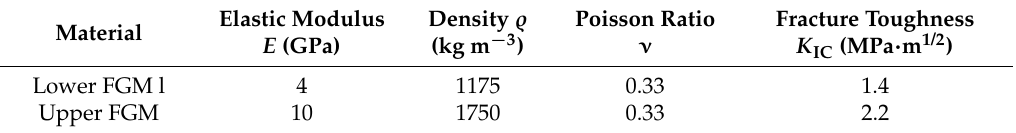
Figure 3. Specimen geometric and boundary conditions. Table 1. Material parameters of functional gradient material (FGM) coating samples.